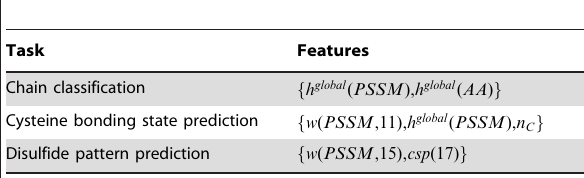
The feature functions were determined by the application of our selection algorithm on top of extremely randomized trees, using the SPX { dataset for chain classification and cysteine bonding state prediction and the SPX z dataset for disulfide pattern